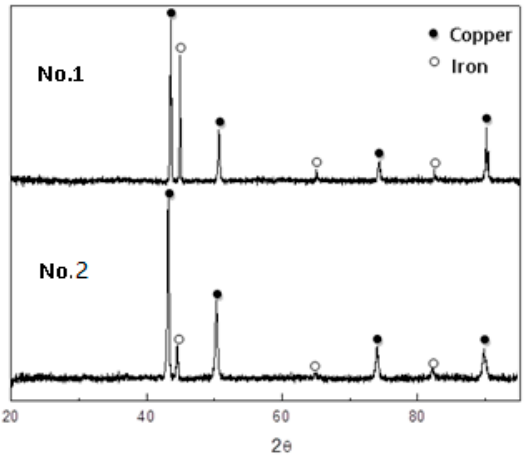
Figure 4. X-ray di ff raction (XRD) patterns on the surface of descaled steels 1 and Figure 4. X-ray diffraction ( . XRD) patterns on the surface of descaled steels 1 and 2.